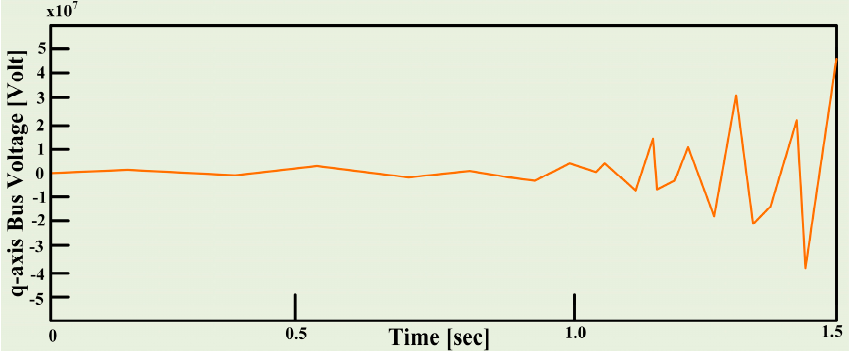
Figure 5. q-axis bus voltage instability due to CPL.